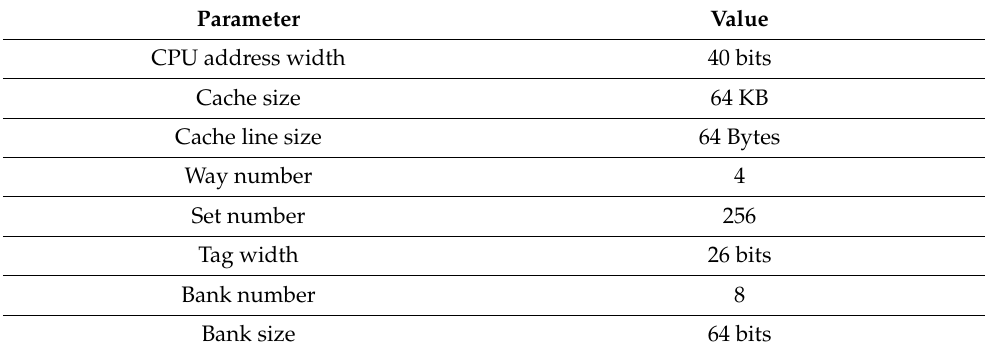
Table 1. Cache parameter and configuration.